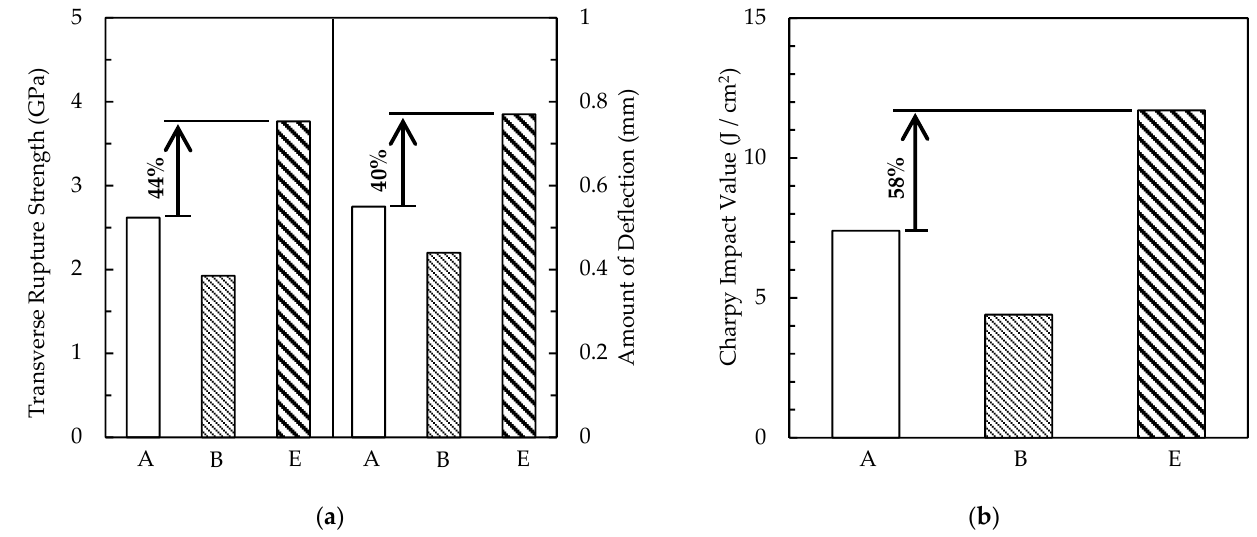
Figure 9. Results of bend and impact tests on specimen A (cast-forged material), B (sintered body), and E (sintered–hot isostatically pressed body). S–HIP significantly improved strength and toughness. ( a ) Comparison of strength and deflection among specimens A, B, and E; ( b ) comparison of toughness among specimens A, B, and E.